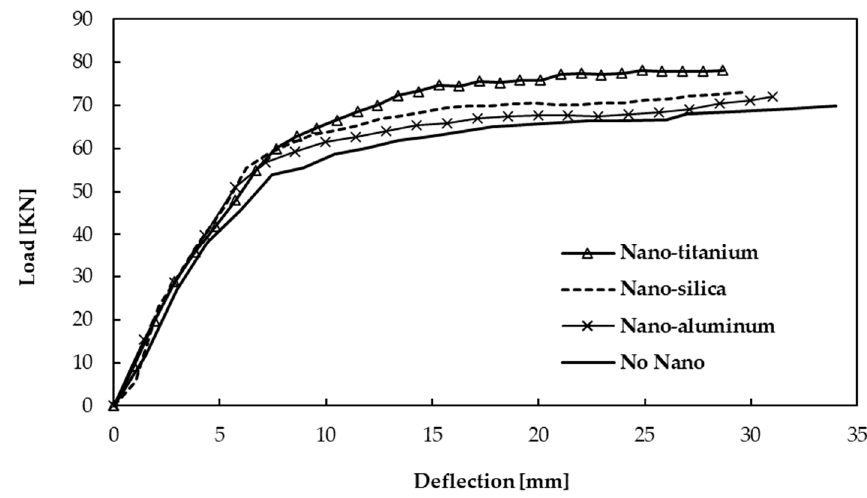
Figure 3. Load deflection curves for all tested beams.